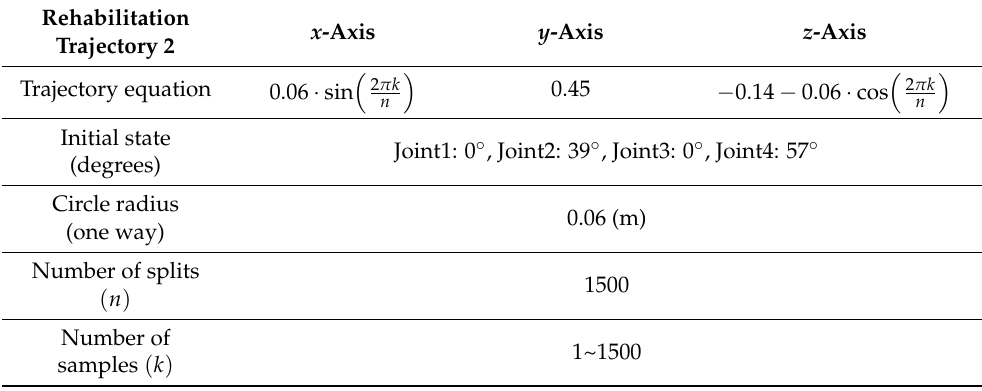
Table 8. Rehabilitation trajectory 2—curvilinear equation in